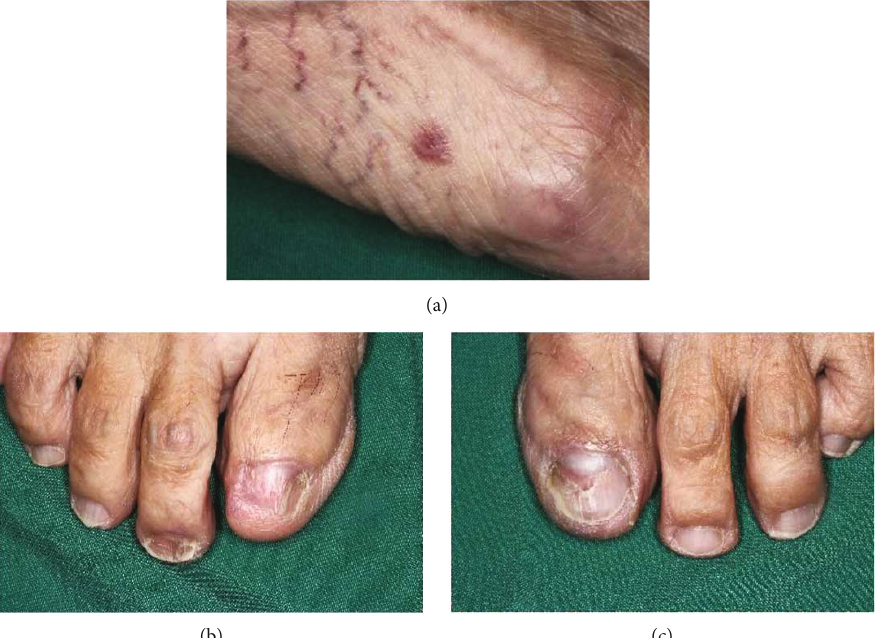
Figure 2: Extraoral examination revealed a polygonal purple papule with white striation on the dorsal surface of the foot (a) and dystrophic toenails (b, c).